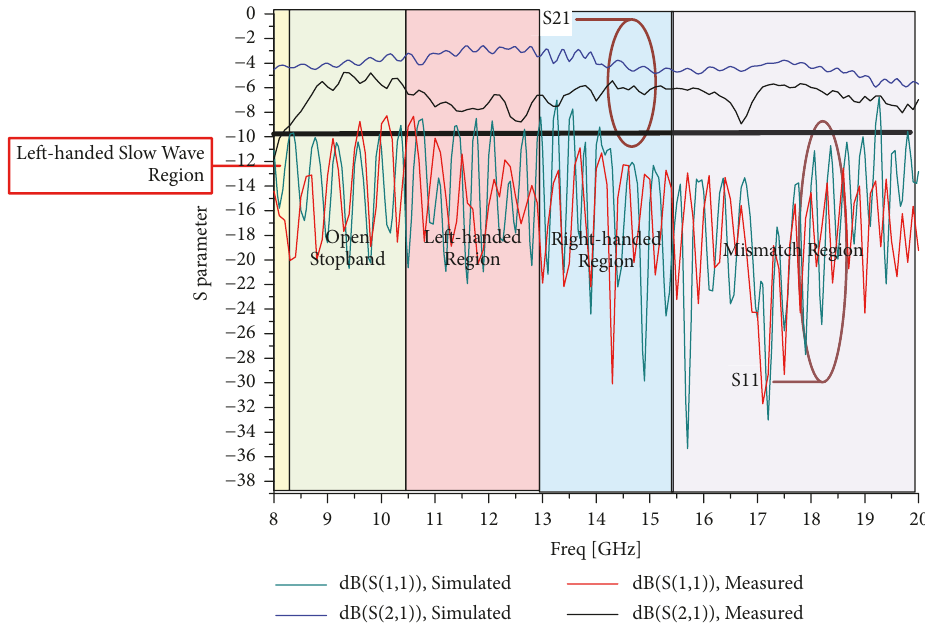
Figure 16: Simulated and measured results of S parameters of proposed antenna.